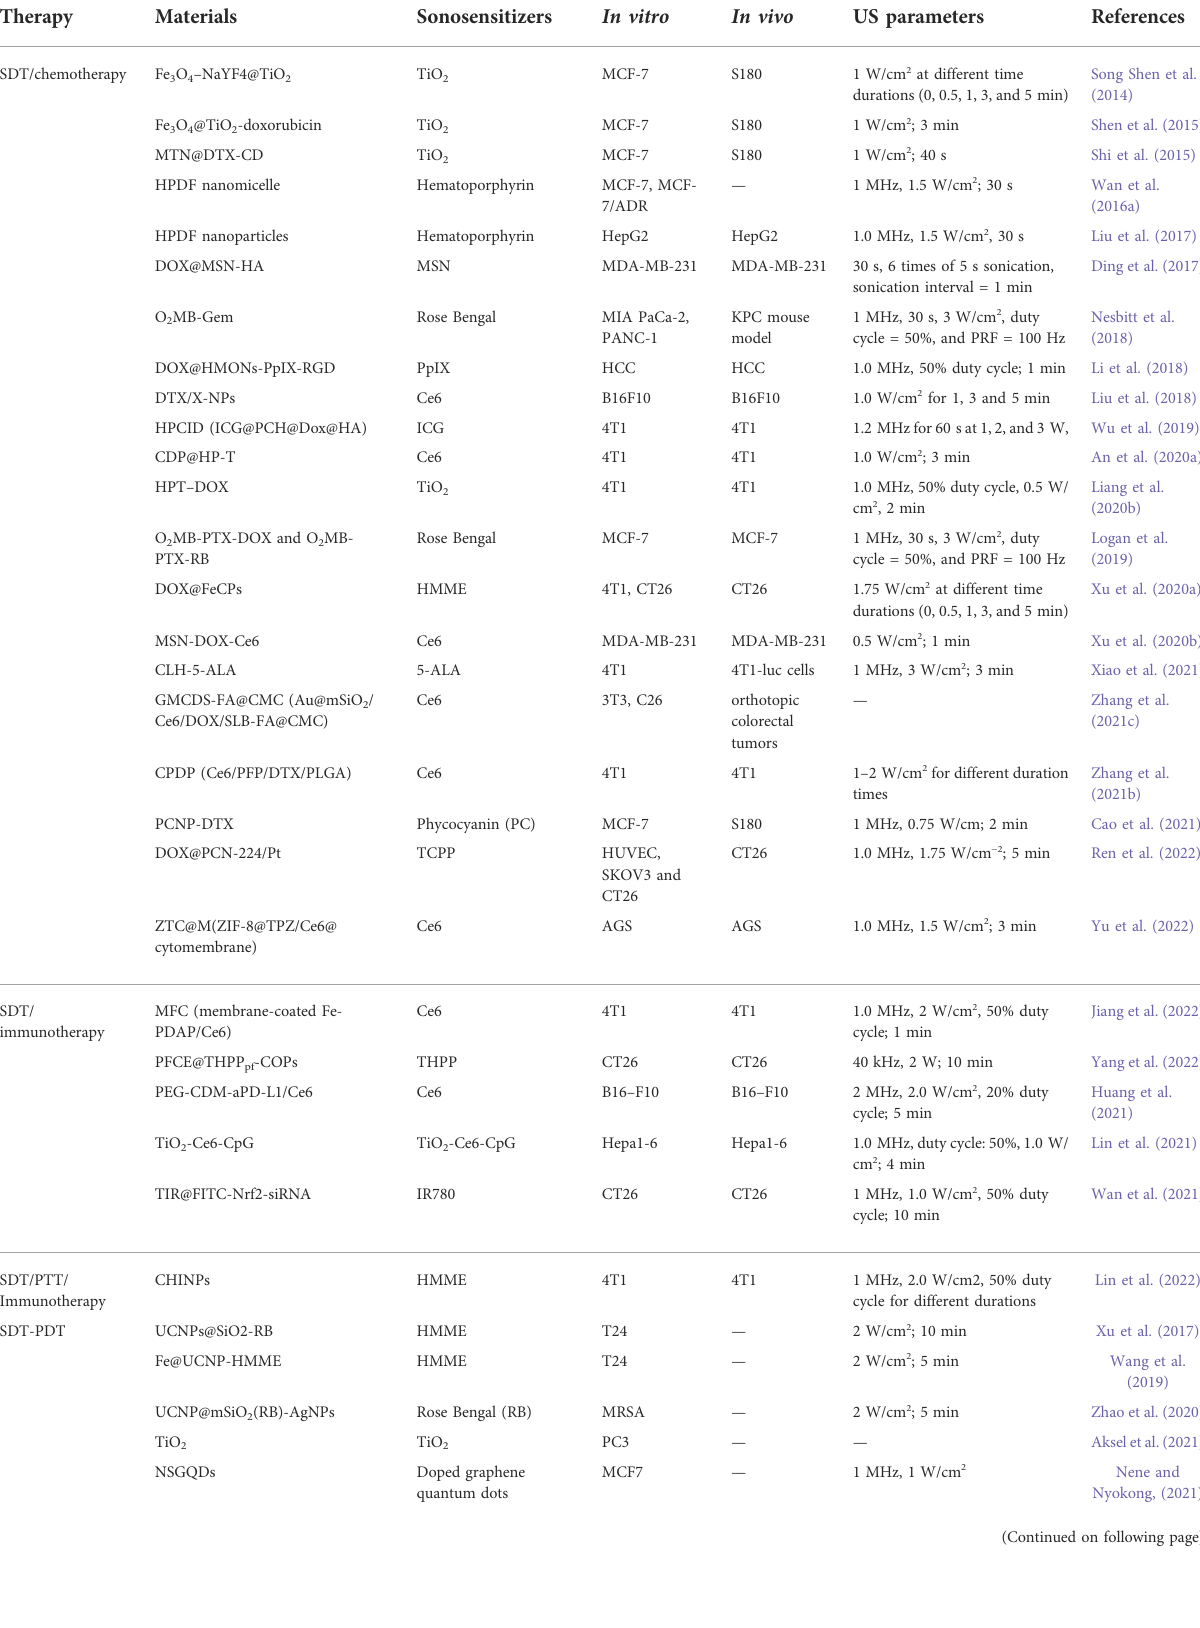
TABLE 3 Category of combination therapy based on SDT in recent years. Therapy